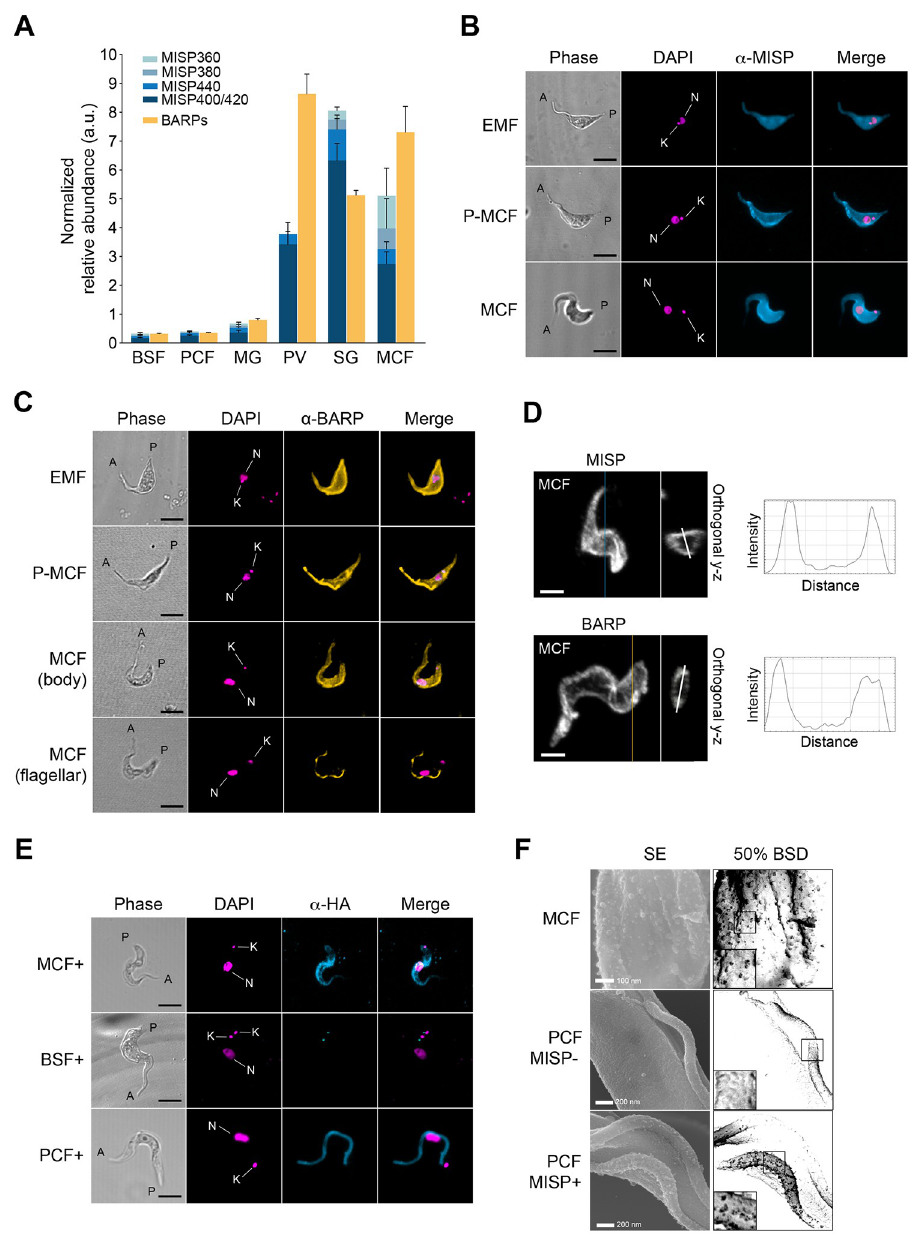
Fig 2. Expression and localization of MISP and BARP. ( A ) Relative mRNA expression levels (arbitrary units, normalized to the expression of tert ) of T . b . brucei misp paralogs (blue) and barp (yellow), in cultured bloodstream forms (BSF), procyclic cultured forms (PCF), midgut procyclics (MG), proventricular forms (PV), salivary gland forms (SG) and purified metacyclic forms (MCF). Bars represent mean values; error bars represent ± S.D from two technical replicates. ( B ) Representative images of non-permeabilized fixed parasites extracted from infected tsetse salivary glands, immunostained with either anti-MISP ( B ) or anti-BARP ( C ) polyclonal antibodies; epimastigote (EMF), pre- metacyclic (P-MCF) and metacyclic forms (MCF); shown as phase, anti-MISP (cyan) or anti-BARP (yellow), and DAPI (magenta); kinetoplasts (K) and nuclei (N) are annotated in the DAPI channel; anterior (A) and posterior (P) ends of the parasite are annotated in the Phase channel. ( D ) Maximum intensity projection of representative metacyclic cells immunostained with anti-MISP (top) or anti-BARP (bottom) polyclonal antibodies and 3D- reconstructed from z-stacks; y-z orthogonal views show surface localization of the signal and graphs on the right plot fluorescence intensity over the white line crossing the cell section. ( E ) Localization of anti-HA monoclonal antibodies on metacyclic (MCF), bloodstream form (BSF) and procyclic cultured form (PCF) transgenic T . b . brucei cells overexpressing ectopic HA-tagged MISP360 upon doxycycline induction; shown as phase, anti-HA (cyan), DAPI